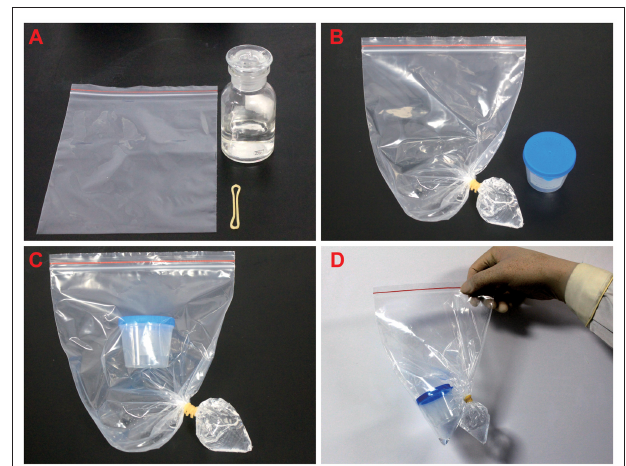
FIGURE 1 | The processing of pathological samples. (A) Prepare 75% alcohol, rubber bands, and seal bag before the experiment. (B) The alcohol was injected into the sealed bag and the corner of the bag was fastened with a rubber band and the bag was sealed. (C,D) The sample box containing sputum was transferred to the sealed bag, and then the specimen bag was